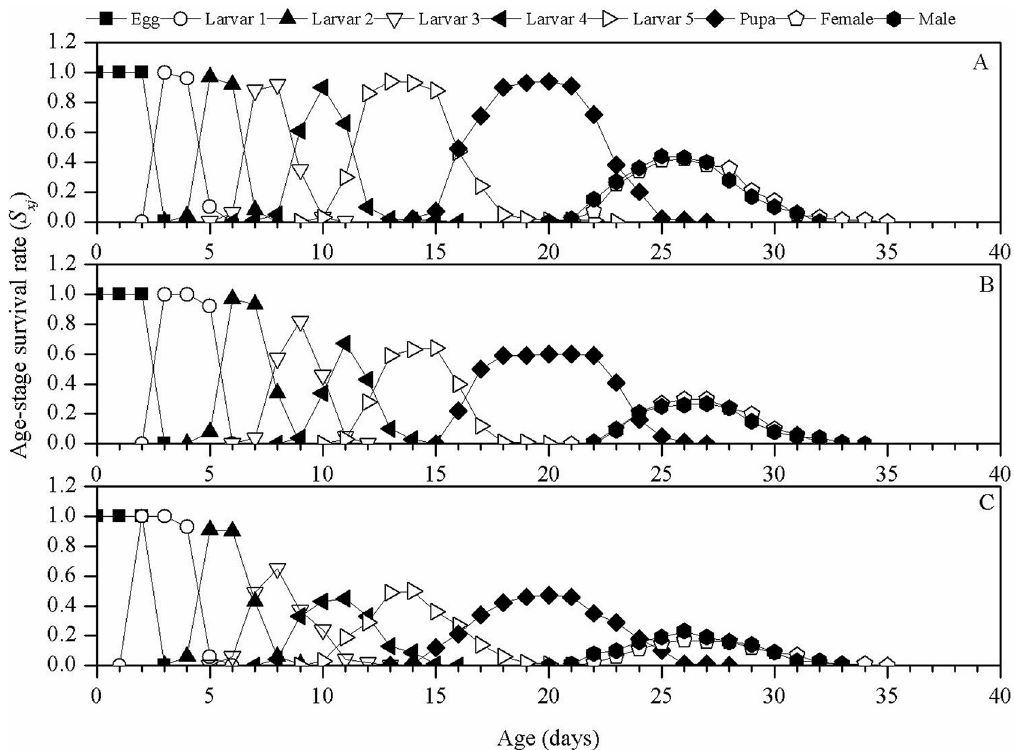
Fig 2. Age-stage specific survival rate ( S xj ) curves of S . exigua treated with sublethal concentrations of TCAP. A, control; B, LC 10 group; and C, LC 30